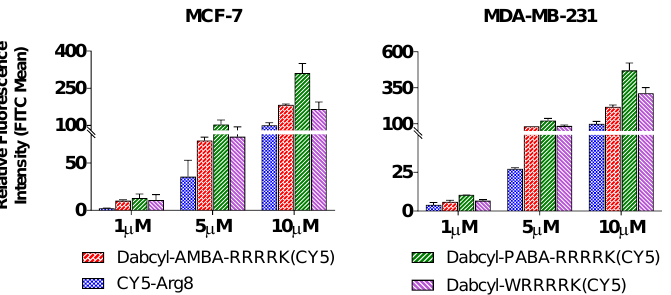
Figure 3. Cellular uptake of peptides on MCF-7 and MDA-MB-231 cells. Cells were treated with 1, 5 and 10 µM peptide solutions for 90 min. The fluorescence intensity of the cells was determined by flow cytometry after trypsin treatment. The fluorescence intensity is relative to Arg 8 at 10 µM (100 %).